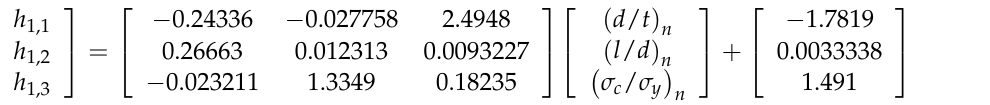
Upon training the ANN model, specific constant values were obtained for the weights and biases as represented by Equations